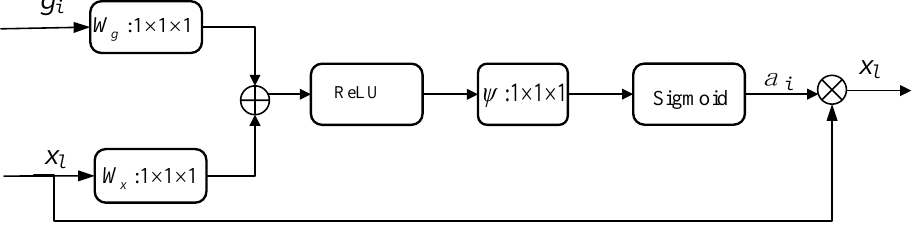
Figure 6. The architecture of the AG spatial attention module.